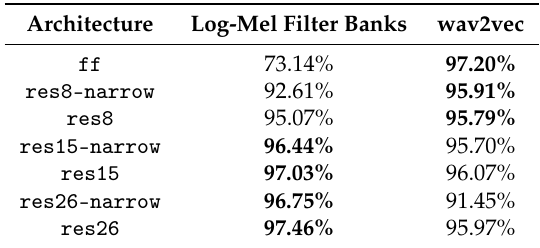
Table 3. Test accuracy on the full English dataset.